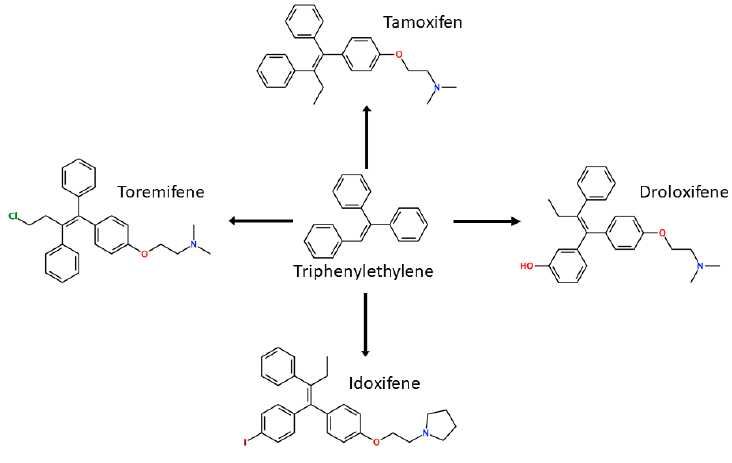
Figure 6. Common triphenylethylene core used to build tamoxifen, toremifene, droloxifene and